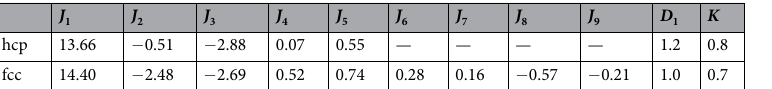
Table 1. Exchange constants, DMI and magnetocrystalline anisotropy obtained from DFT for hcp-Pd/Fe/ Ir(111) and fcc-Pd/Fe/Ir(111). The positive sign of the DMI indicates favoring of right rotating spin spirals and the positive sign of K indicates an easy out-of-plane magnetization direction. The coefficients are given in meV.